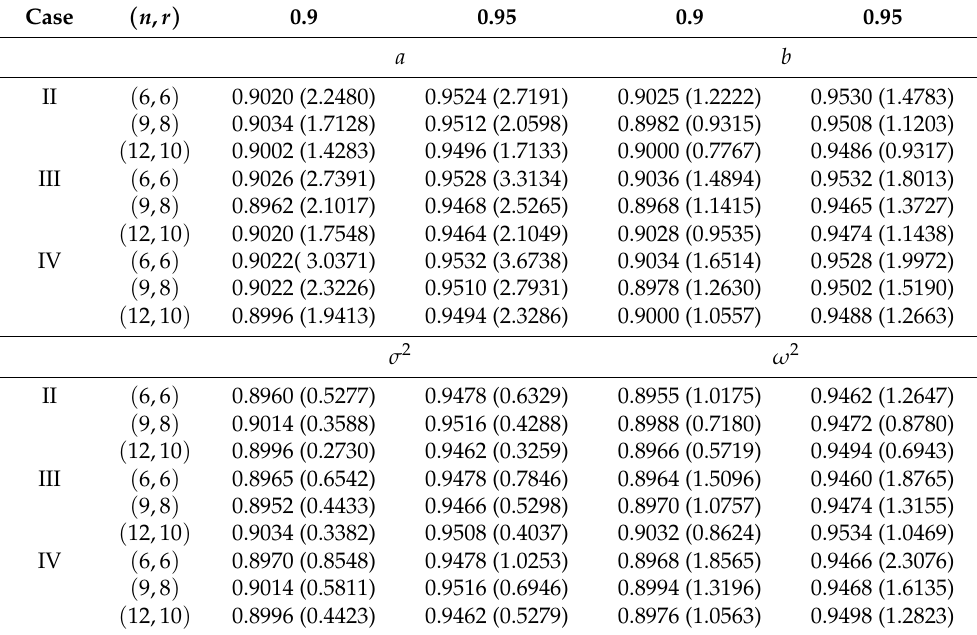
Table 2. The CPs and AILs (in parentheses) of parameters a , b , σ 2 and ω 2 for nominal levels 0.9, 0.95, based on 5000 replications.